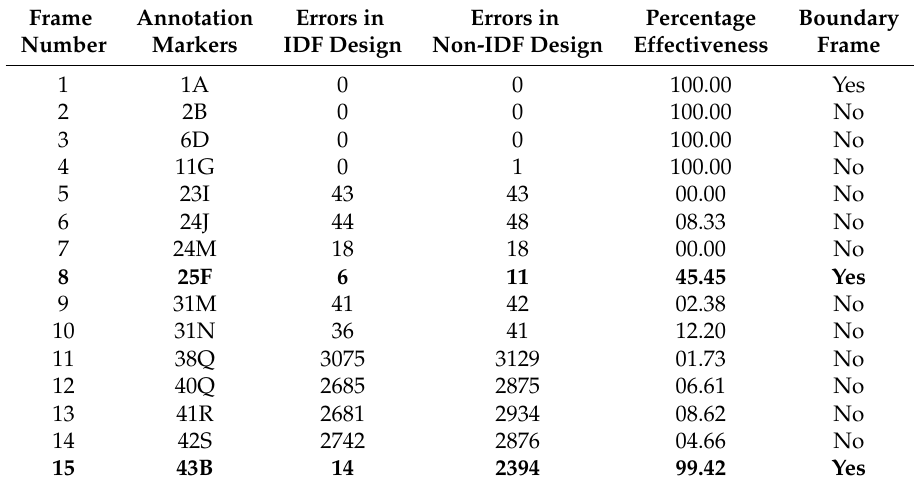
Figure 5. IDF Design, Implementation view with Controller marked in Green, AES_Zero marked in Blue, AES_One in Purple and Comparator marked in Yellow. Table 2. Error Rate Comparison for IDF and Non-IDF-Based Design (Annotated Markers in Figure